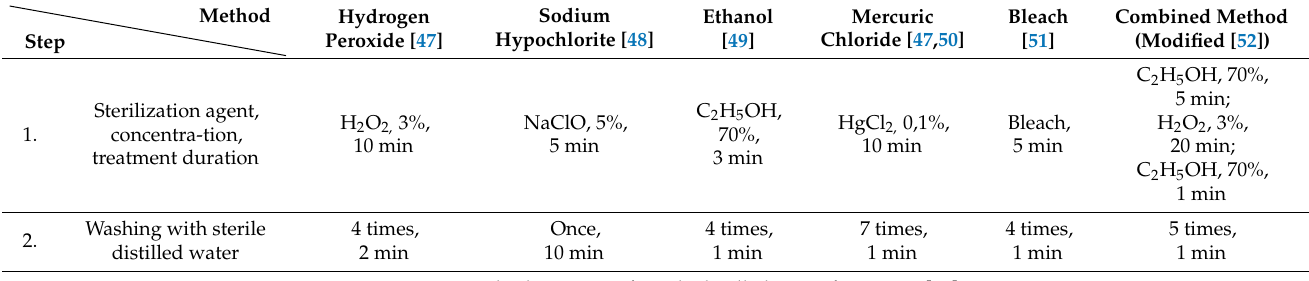
Table 1. Sterilization methods used for isolating endophytic bacteria from European plum